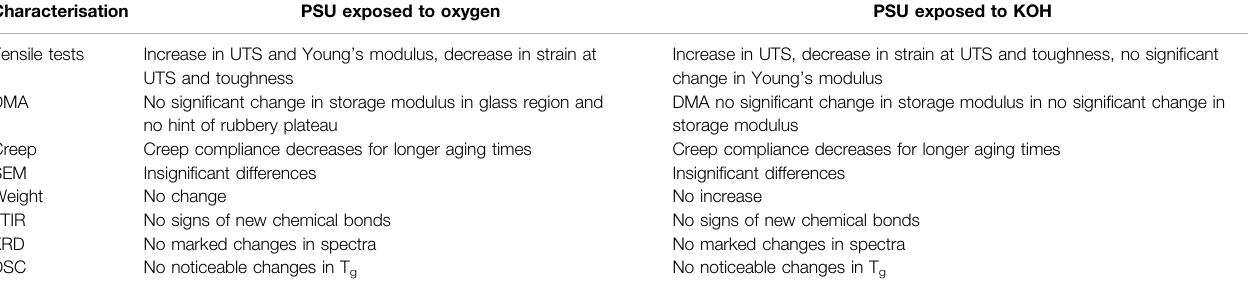
TABLE 4 | Results of PSU exposed to oxygen and KOH.